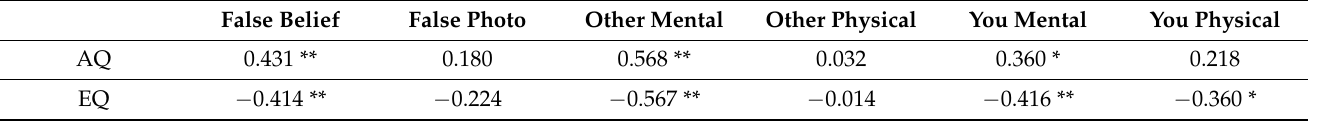
Table 2. Correlations between AQ, EQ and reaction times in ToM tasks. False